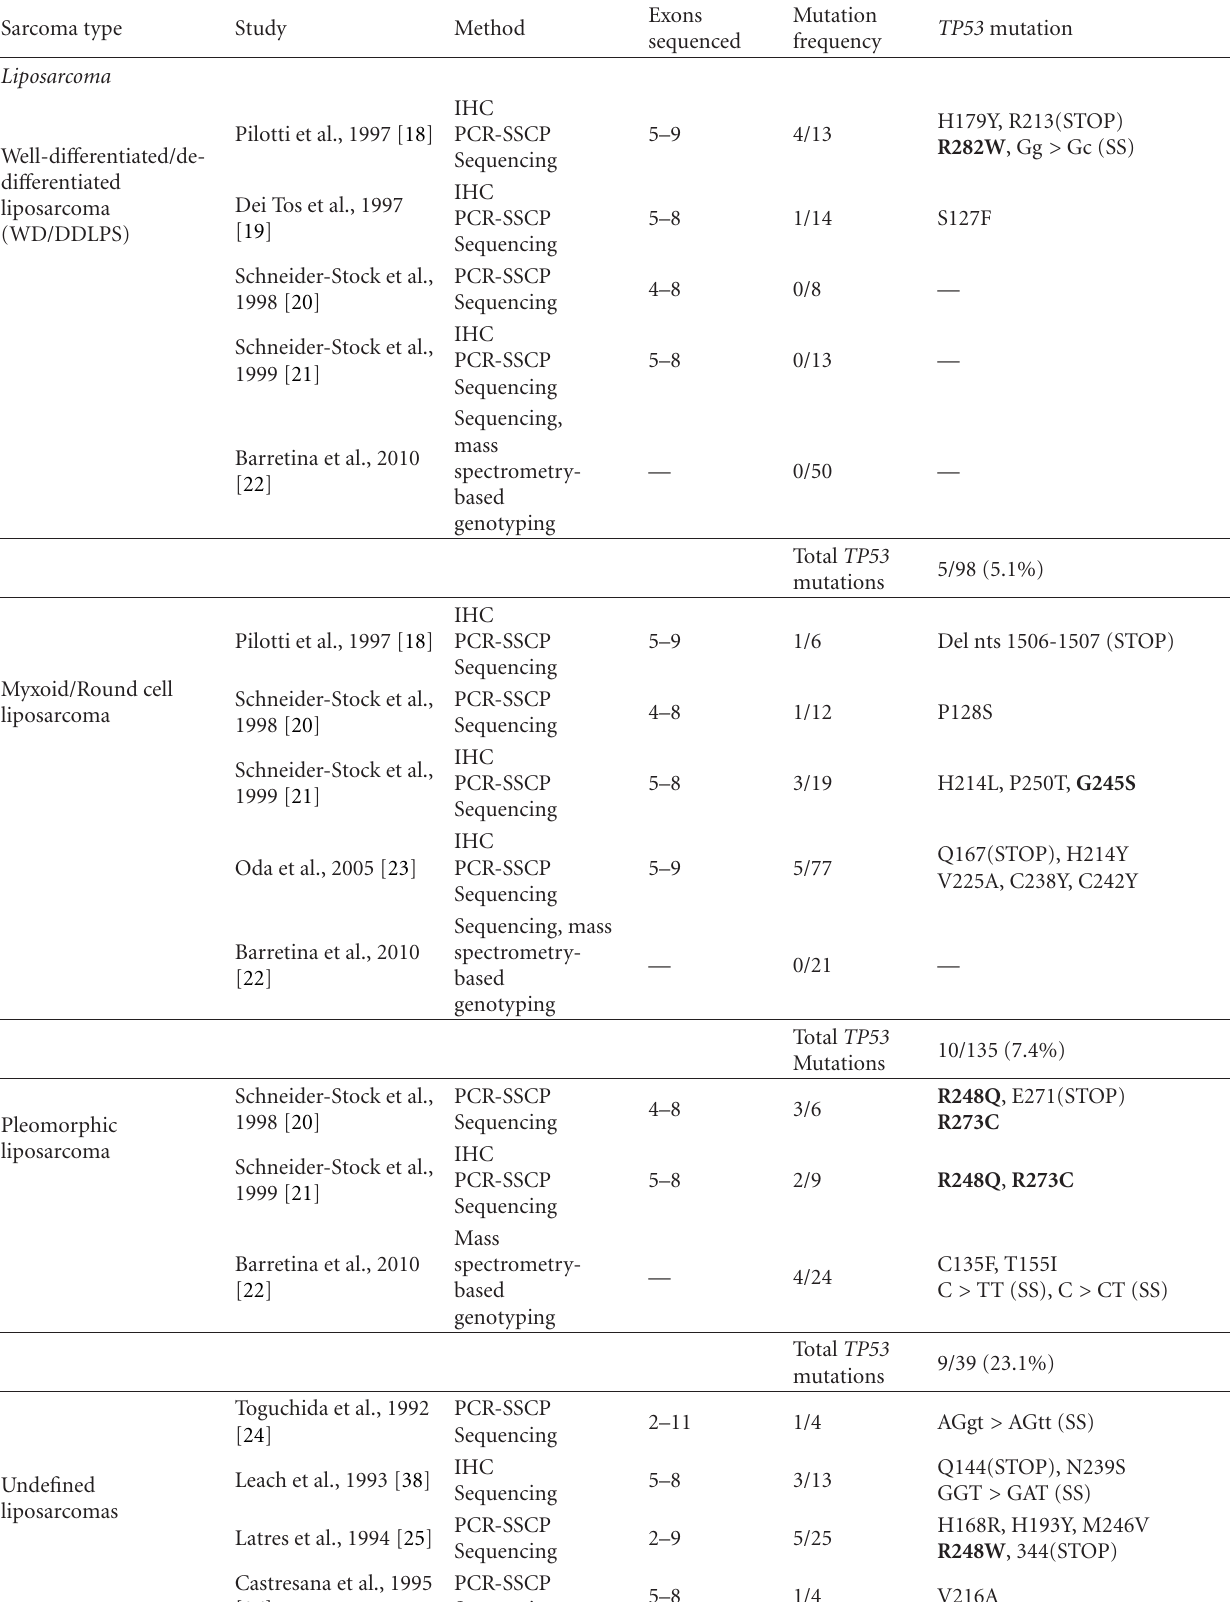
Table 2: TP53 Mutations in sarcomas other than ESFTs confirmed by DNA